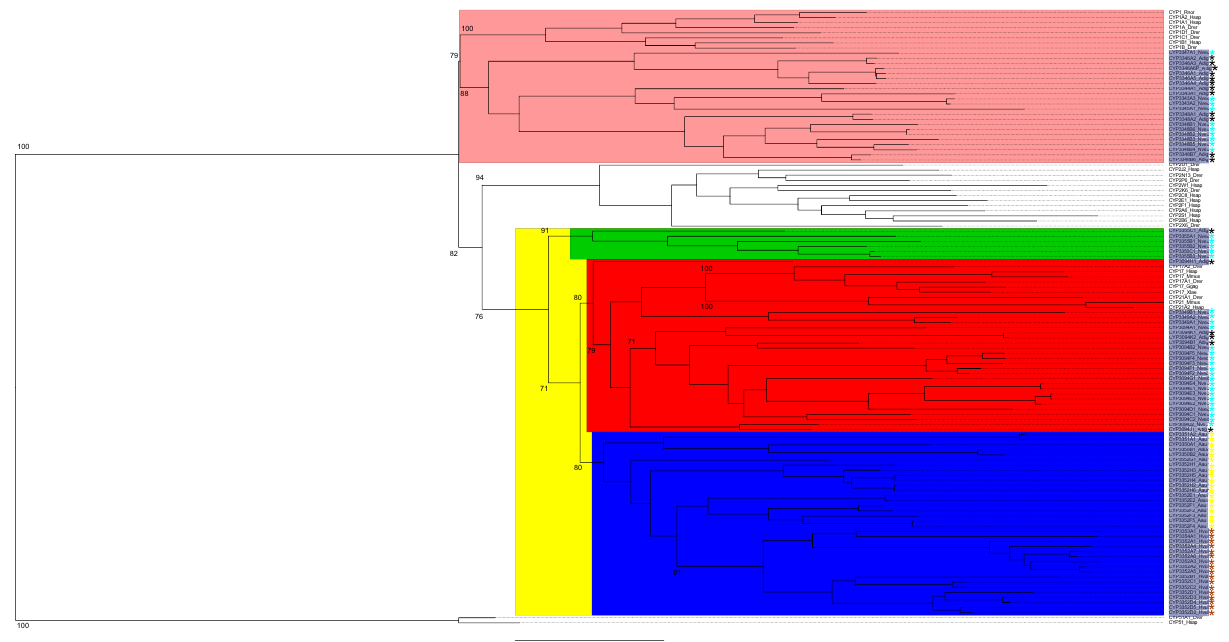
Figure 4. Maximum-likelihood phylogenetic tree of cnidarian clan 2 cytochrome P450 enzymes. The tree was generated with rapid bootstrapping and a gamma distribution with the JTT substitution matrix. The CYP1 family and a sister cnidarian clade are salmon. The yellow branch identifies a large group of cnidarian CYPs and the vertebrate CYP17 and CYP21 families; this branch is further divided based on evolutionary distance to the vertebrate CYPs (blue is almost all CYPs that clustered directly with the vertebrate sequences, while the red and green groups both clustered outside of the vertebrate sequences). The cnidarian CYP names are highlighted in dark grey on the tree. The different coloured asterisks indicate which cnidarian each CYP is from: H. vulgaris is brown, A. digitifera is black, A. aurita is yellow, N. vectensis is turquoise. The tree is rooted with the CYP51 family. Bootstrap values for major CYP family divisions and major cnidarian clades are indicated on the tree. Species acronyms are based on the family and species: Drer—zebrafish, Ggal—chicken, Hsap—human, Mmus— mouse, Rnor- rat, Xlae—frog, Hvul—brown hydra, Adig—stony coral, Aaur—moon jellyfish, Nvec—starlet sea